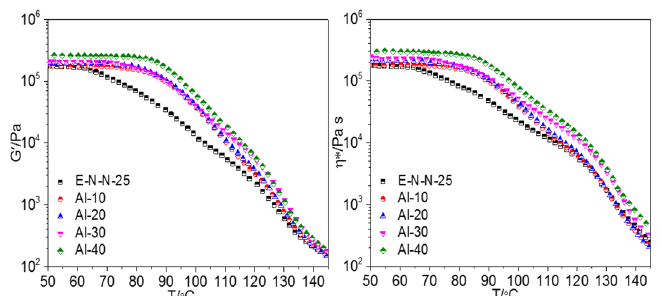
Figure 1. Temperature dependencies of ( left ) storage modulus G’ and ( right ) complex viscosity η * of model propellants with different Al contents.